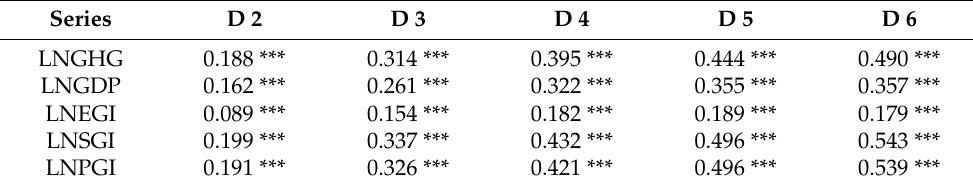
Table 3. Results of BDS non-linearity test.